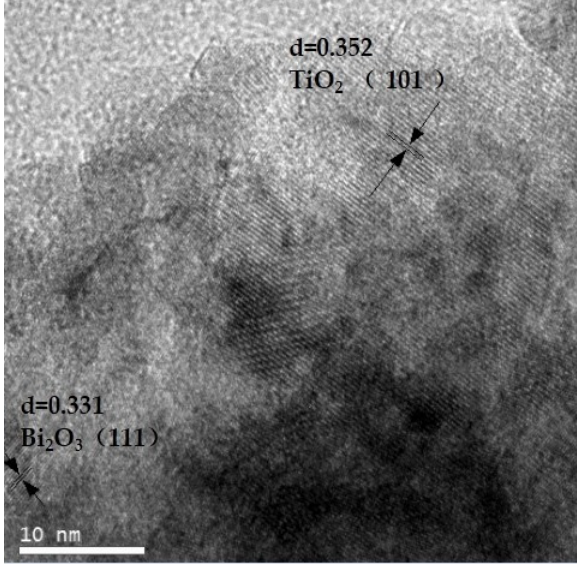
Figure 8. HRTEM image of Si–Ti composite film surface of the BSTS sample.